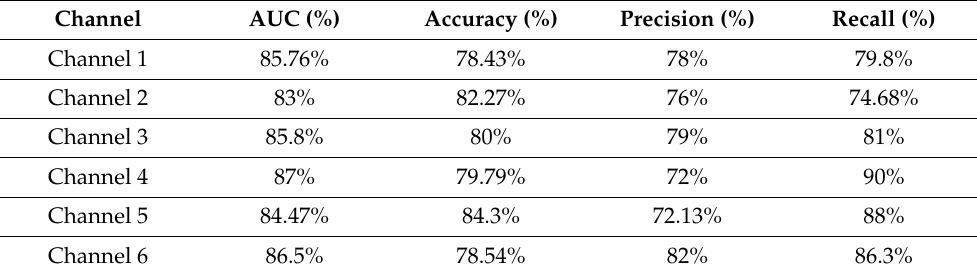
Table 7. Accuracy, area under curve (AUC), precision and recall results for model 2, 10 s epochs.